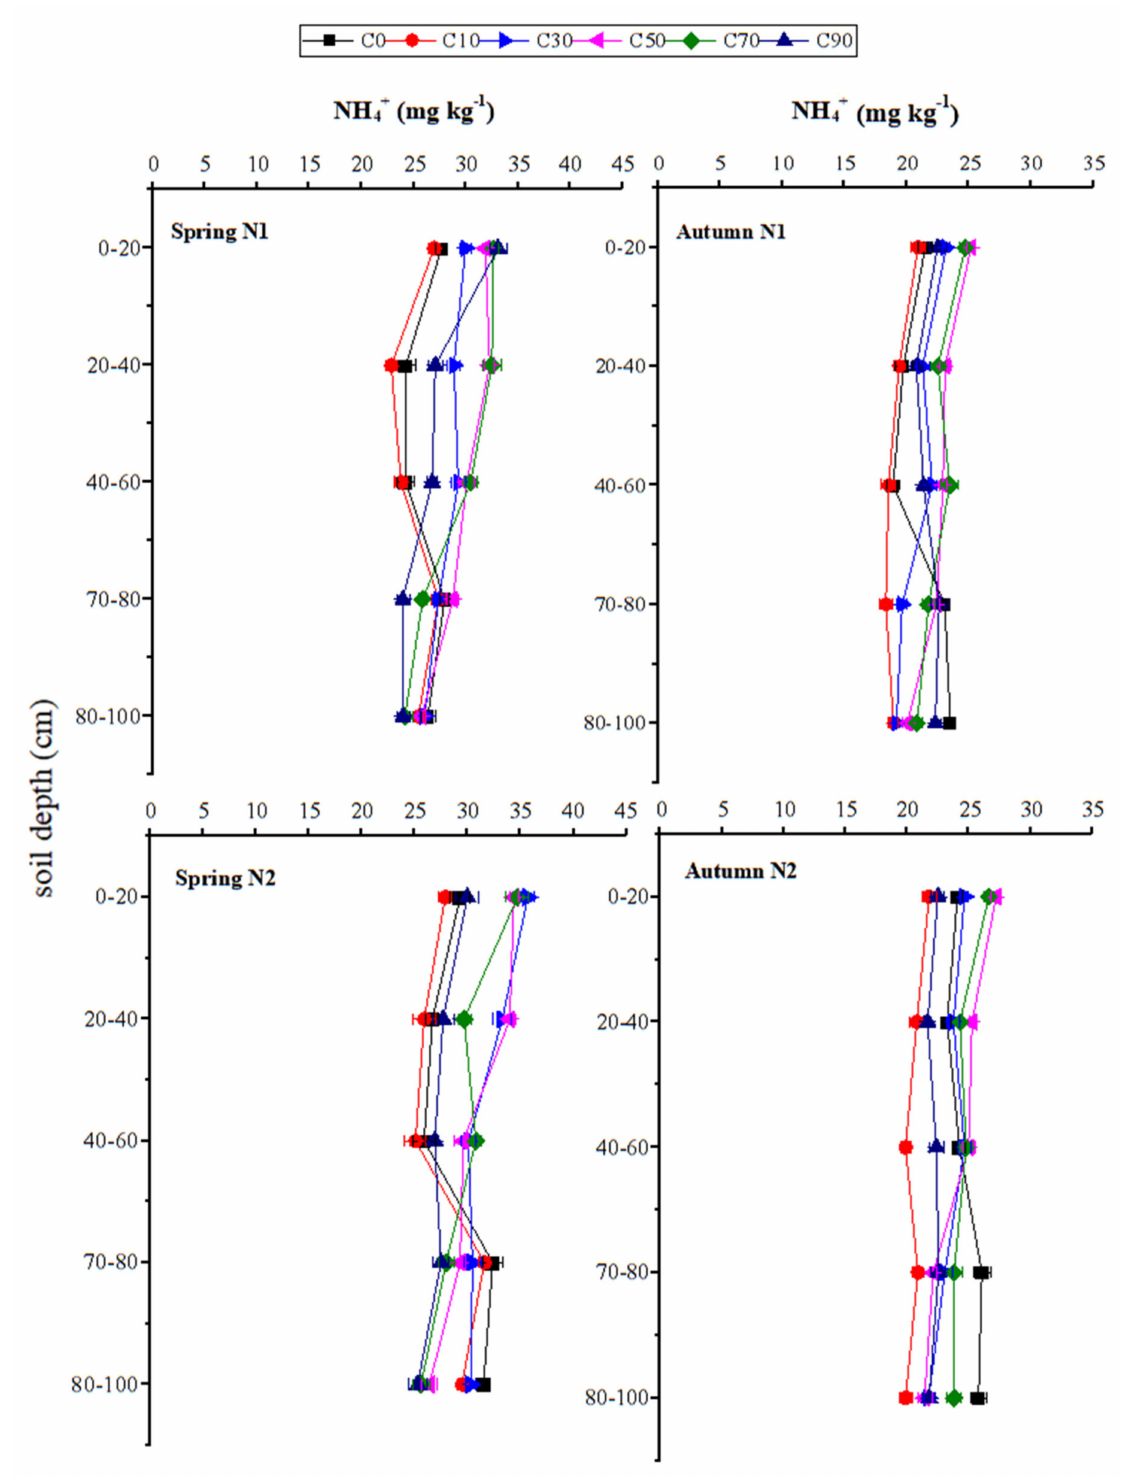
Figure 4. The distribution of NH 4+ at different soil depths for the N fertiliser (N1 and N2) and biochar (C0, C10, C30, C50, C70, and C90) treatments. Error bars represent standard